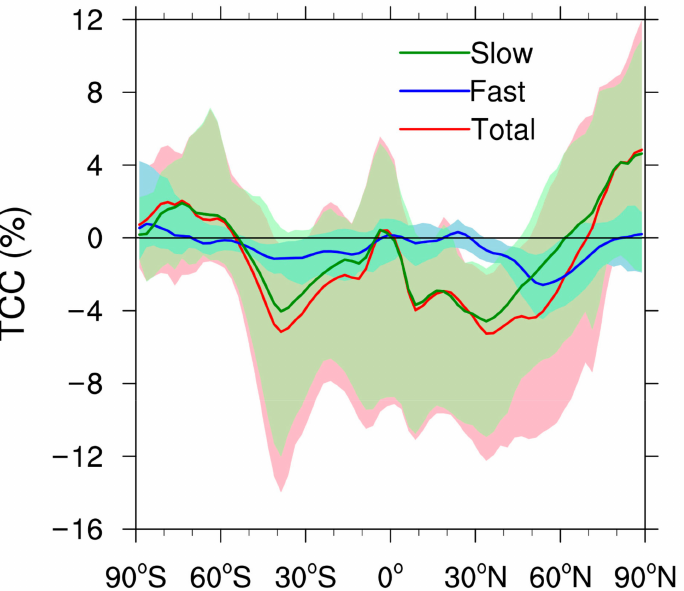
Figure 3. Zonal mean responses of the global total cloud cover (units: %). The red, blue, and green lines represent the total, fast, and slow responses, respectively. The shadows show the maximum and minimum values of the 10 models.